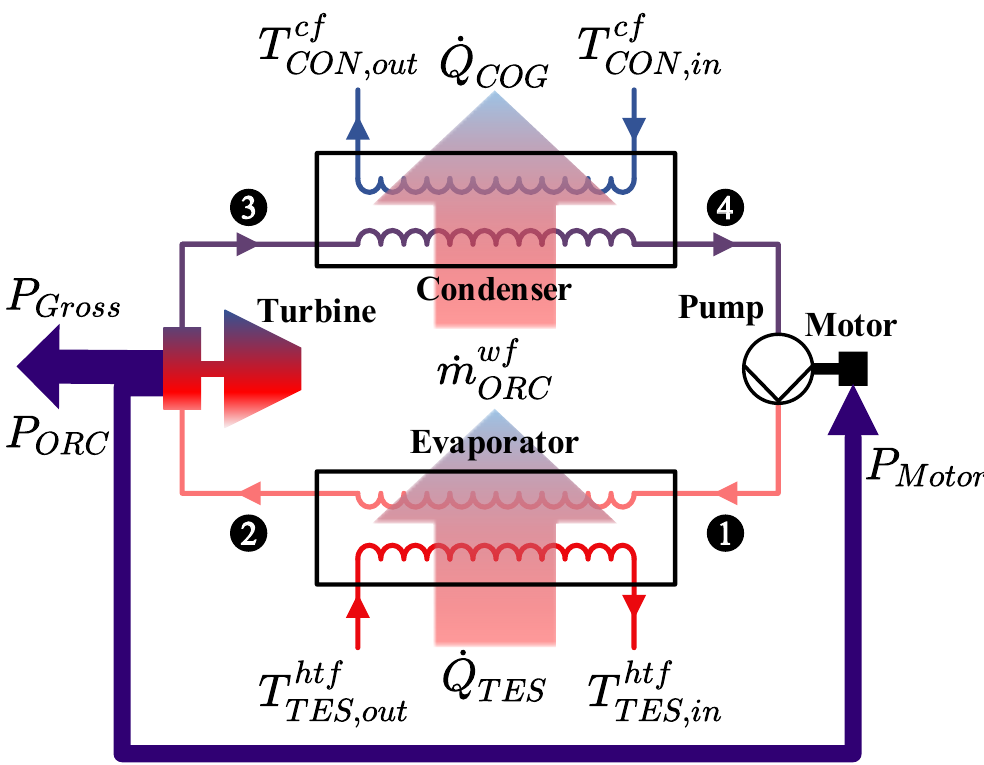
Figure 10. Schematic of the organic Rankine cycle (ORC) system. The circled numbers show the four states of the ORC system. (Adapted from [20] with permission of